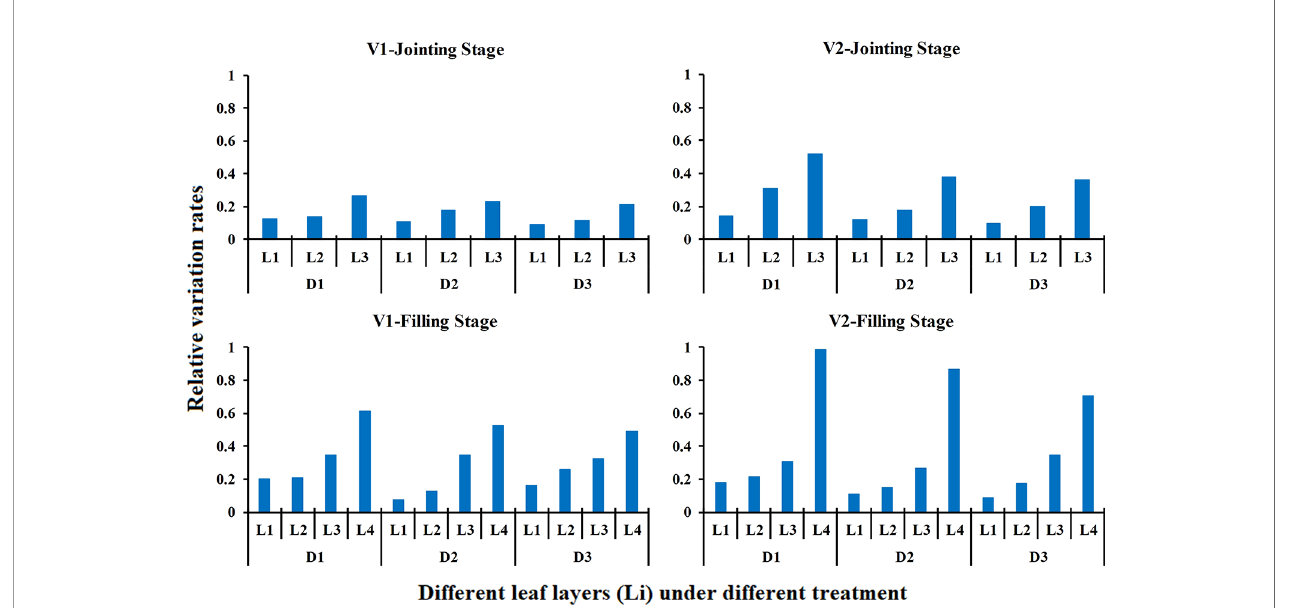
FIGURE 7 | Relative variation rate of the LNC Li in response to different N rates in different growth stage (2015). The relative variation rate is the product of the nitrogen traits under high nitrogen treatment minus the nitrogen traits under low nitrogen treatment over the nitrogen traits under low nitrogen treatment.